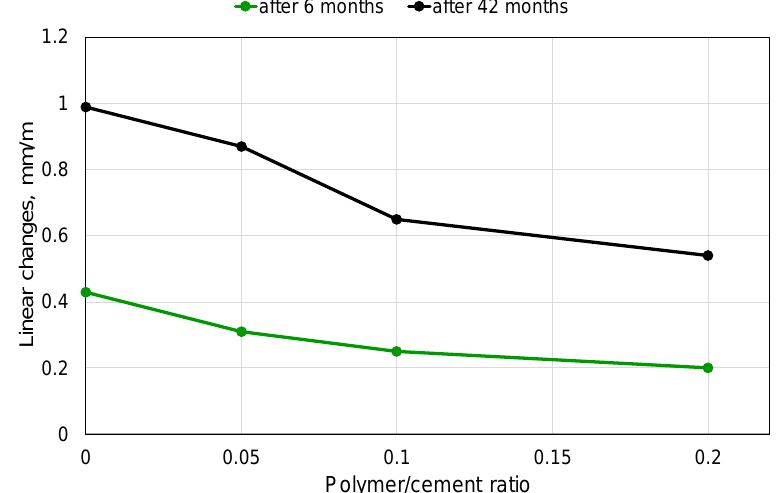
Figure 2. Elongation of mortar specimens with various content of polymer modifier after 6 and 42 months of exposure to the 5% MgSO 4 solution.